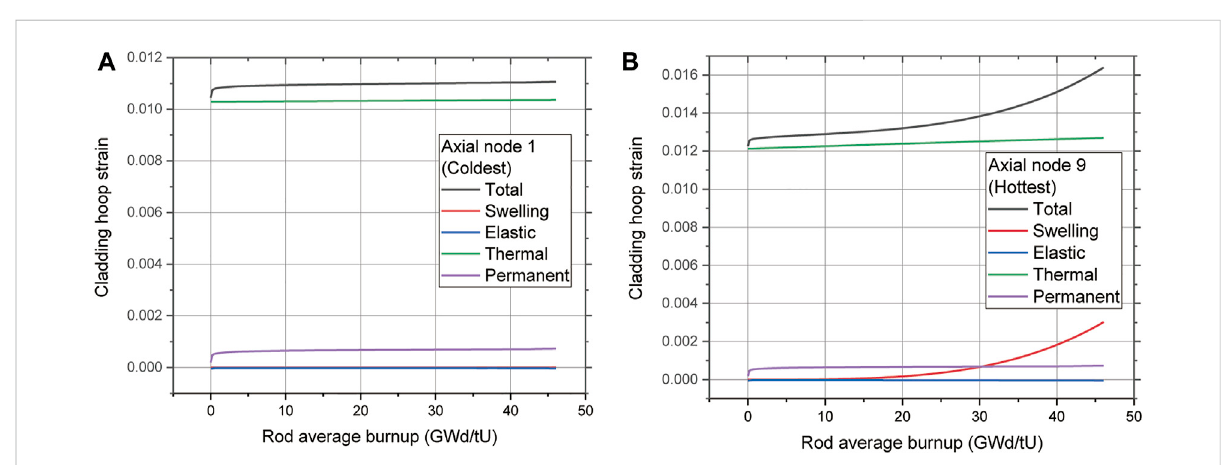
FIGURE 10 Cladding deformation mechanism of (A) coldest axial region and (B) hottest axial